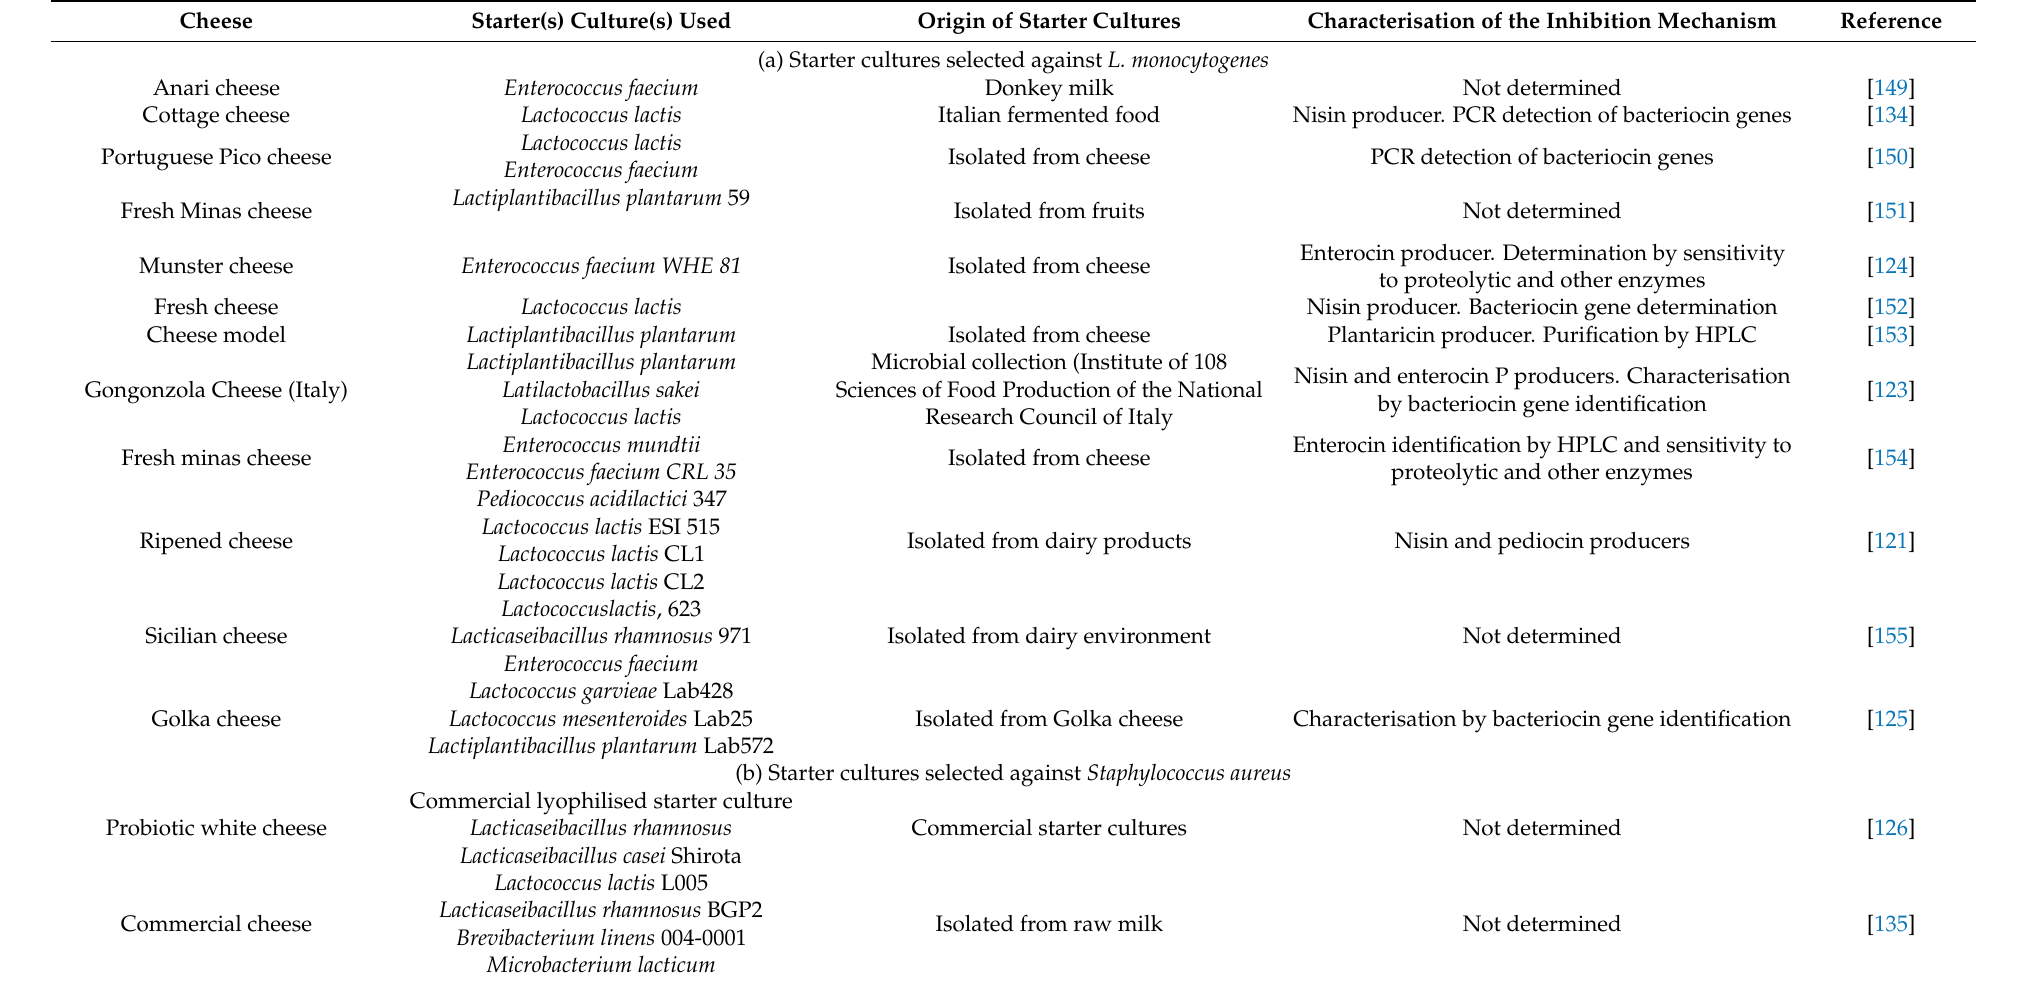
Table 3. Antimicrobial effect of selected starter cultures (added as ingredients during cheese manufacture) against main foodborne